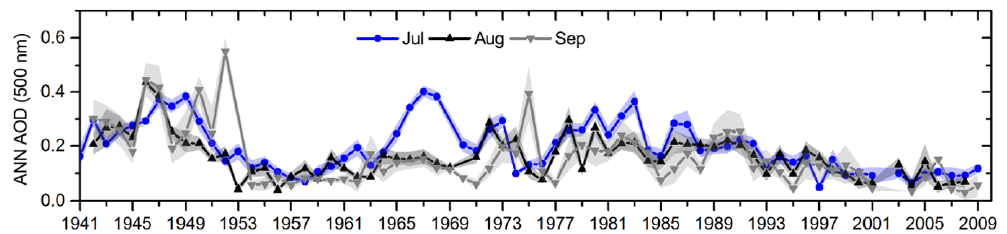
Figure 4. Times series of the ANN AOD monthly medians (July, August and September) at 500nm between 1941 and 2009 at IZO. Shadings show the range of ± 1SEM (standard error of the monthly median).